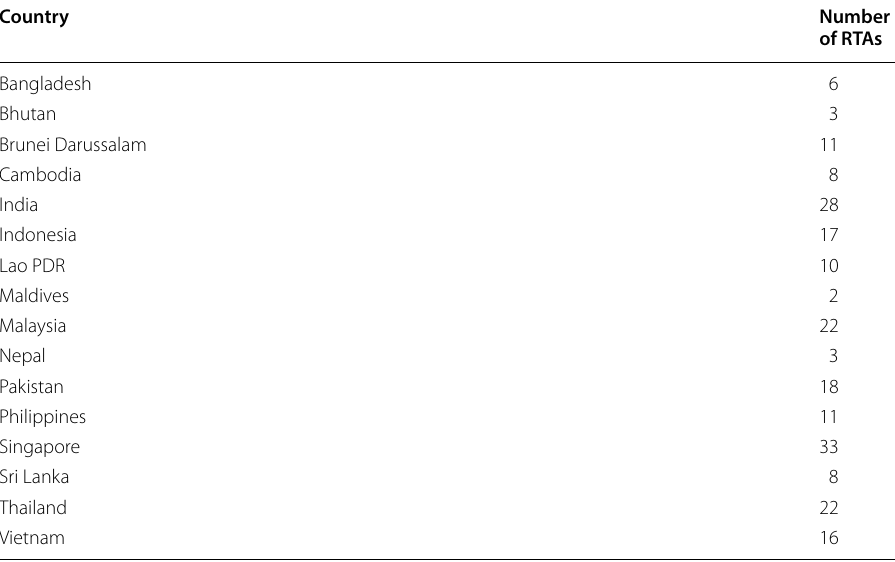
Table 9 Regional trade agreements of South and Southeast Asian Countries. Source Website of ADB (Asian Development